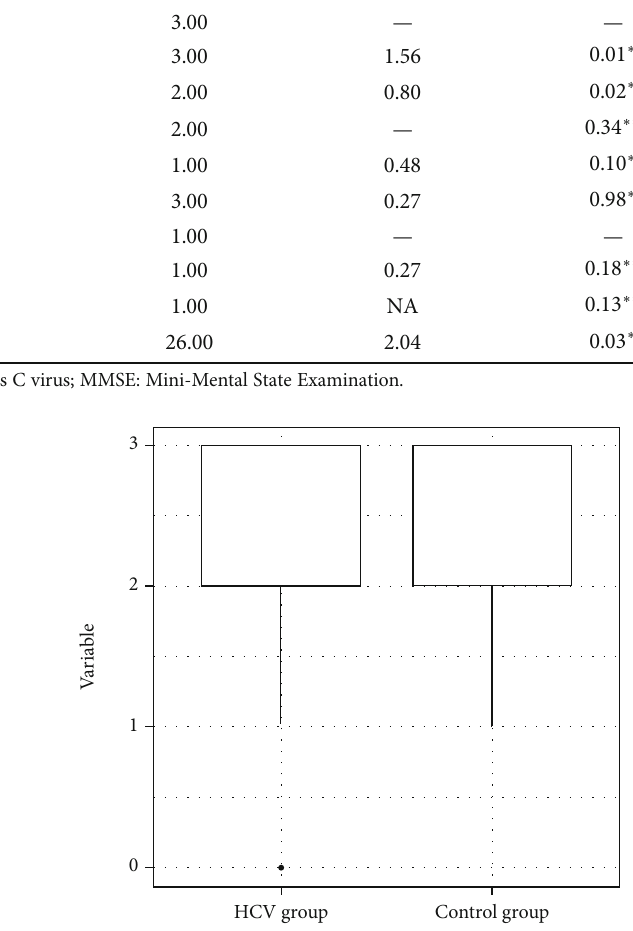
Figure 3: Distribution of the variable Mini-Mental State Examination evocation of word